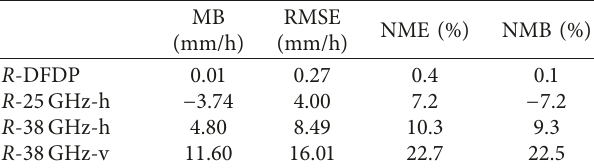
Table 8: Statistical parameters of the second group for R